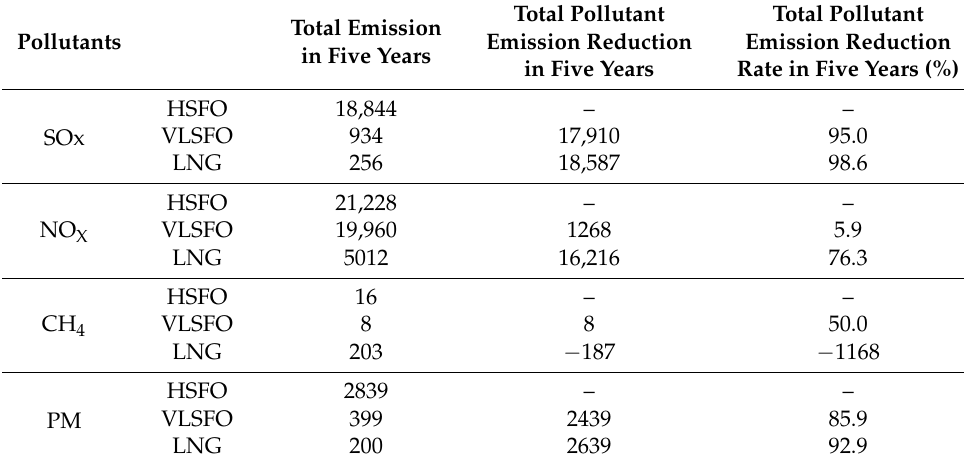
Table 17. Total pollutant emission reduction (in tons) and total pollutant emission reduction rates (in %) with the adoption of the VLSFO and LNG strategies over a five-year period.